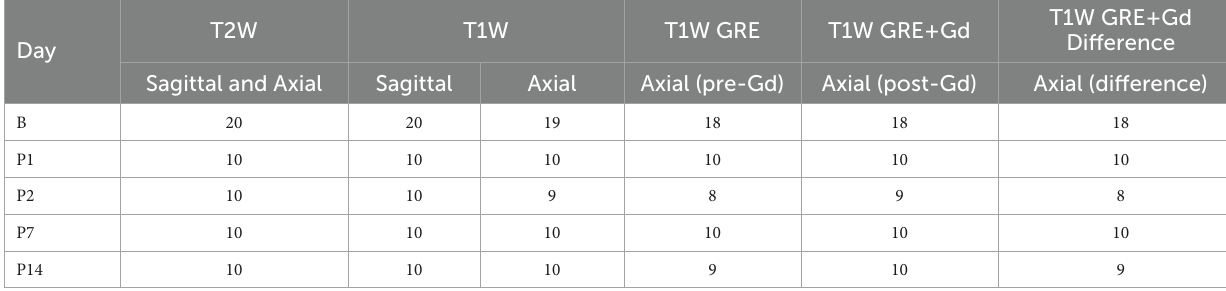
TABLE 4 Number of datasets used in statistical comparisons by MRI scan and